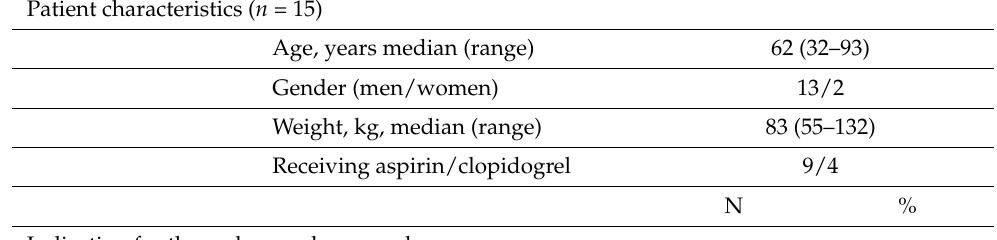
Table 1. Data of 15 patients undergoing endovascular procedure and receiving unfractionated heparin (UFH) as